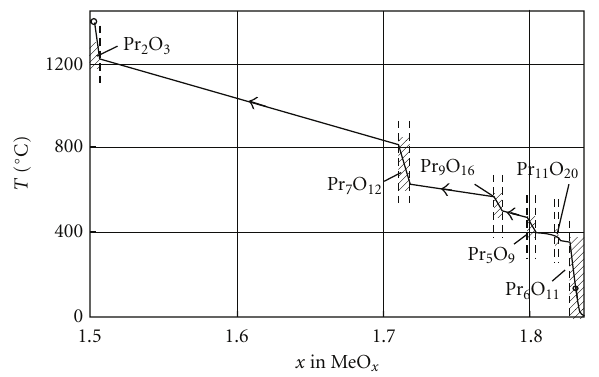
Figure 2: Relation between temperature and composition of the various phases in the praseodymium-oxygen system. Reproduced from Ionics , 1999, 5 , 426. Copyright 1999, Springer-Verlag [6].